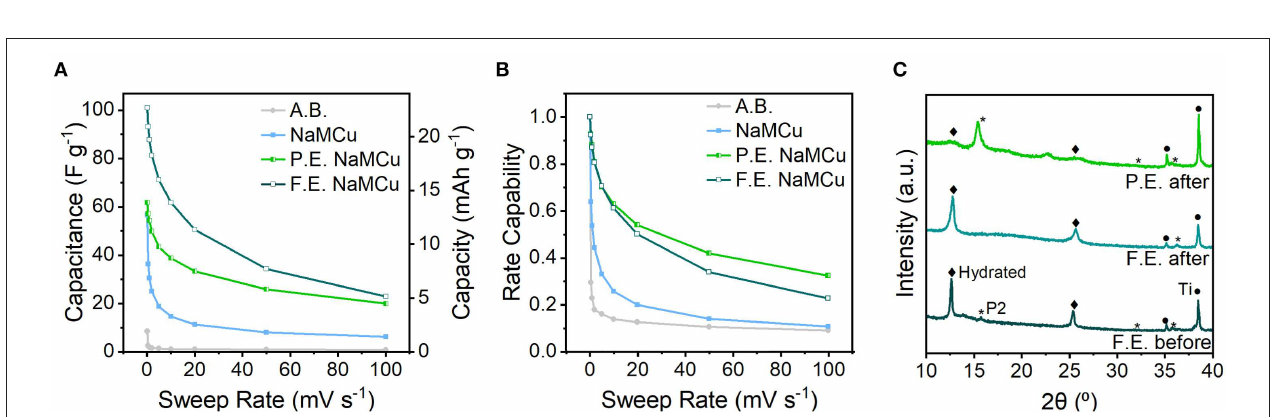
FIGURE 4 | CVs of the pristine P2, P.E., and F.E. NaMCu materials in 0.5M K 2 SO 4 electrolyte at (A) 1 mV/s, (B) 10 mV/s, and (C) 100 mV/s. The specific current from just the acetylene black (A.B.) conductive additive is shown for reference.